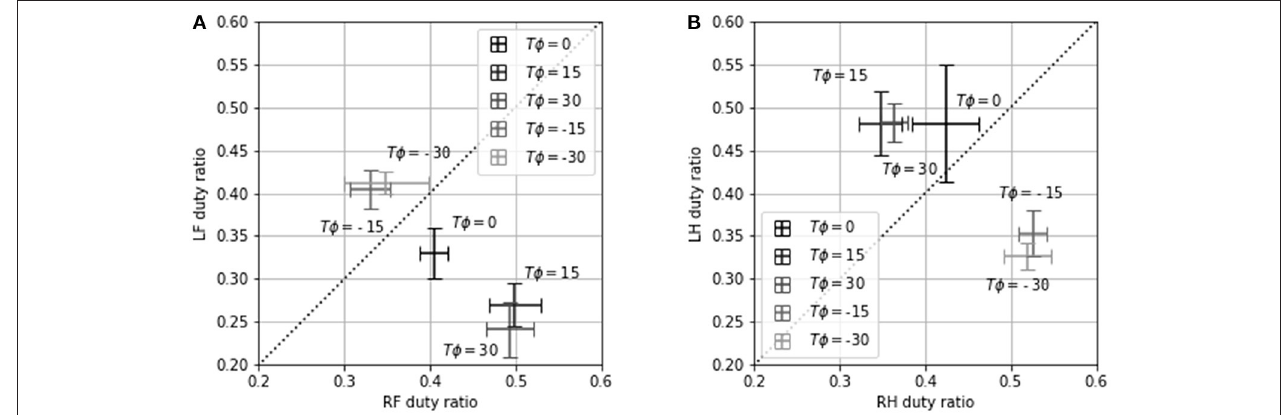
FIGURE 12 | (A) LF duty ratio vs. RF duty ratio and (B) LH duty ratio vs. RH duty ratio for T φ = − 30, − 15,0,15,30. Error bars show one standard